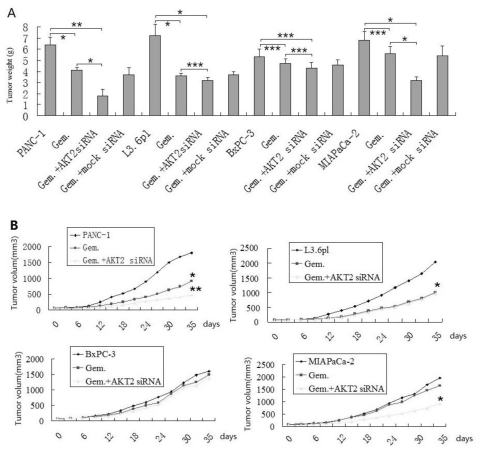
Effect of rAAV2-AKT2 siRNA combined with gemcitabine on tumor growth. (A) Tumor weight in mice treated with vehicle control, gemcitabine (gem.; 80 mg/kg twice weekly, i.v.), rAAV2-AKT2 siRNA combined with gemcitabine, Columns, mean (six samples per group); bars, SD. All statistical tests were two sided (* P < 0.05, ** P < 0.01, *** P > 0.05); (B) Growth curve of L3.6pl, PANC-1, BxPC-3 and MIAPaCa-2 tumors (n = 6 per group) treated with gemcitabine (80 mg/kg twice weekly, i.v.) or rAAV2-AKT2 siRNA combined with gemcitabine. Student’s t test versus control group; * P < 0.05, ** P < 0.01.